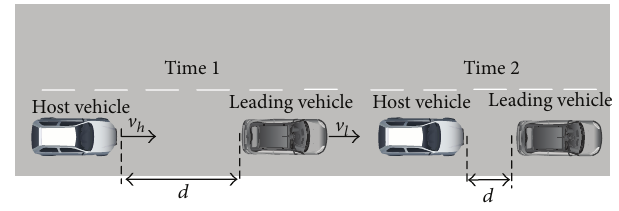
Figure 1: The leading vehicle decelerating and